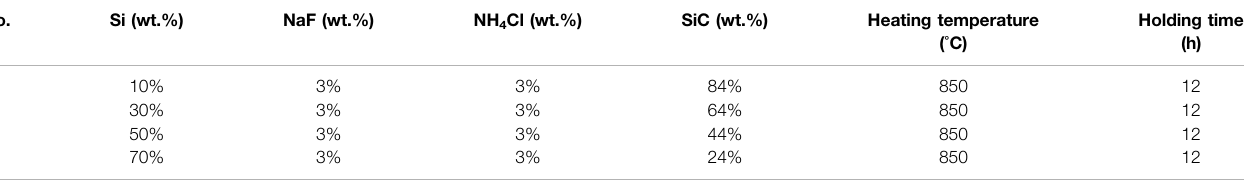
TABLE 2 | Process parameters of test.